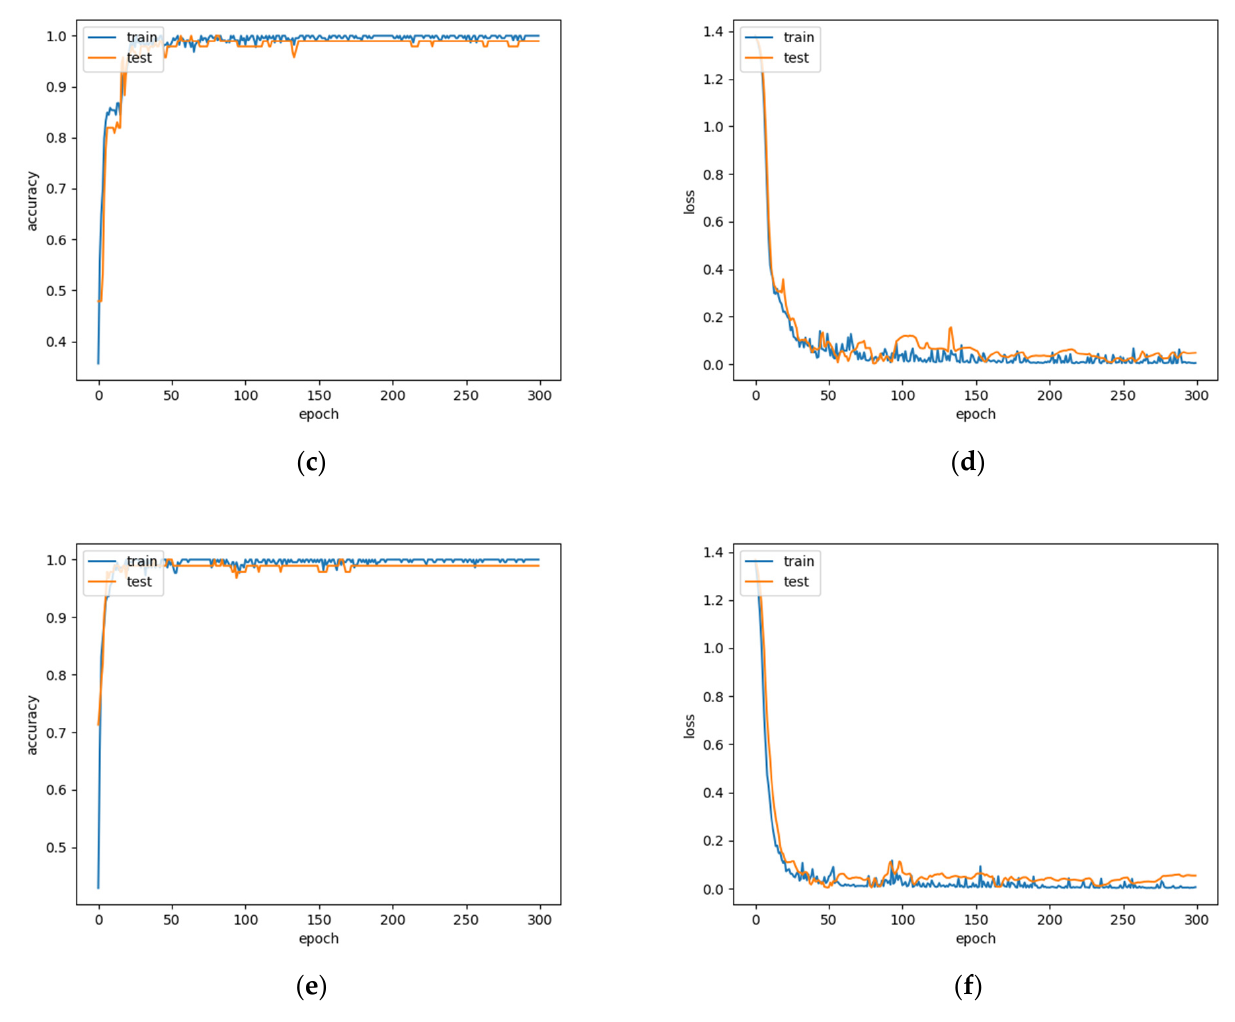
Figure 8. Accuracy and loss for girls’ physical fitness level evaluation. ( a , b ) Accuracy and loss when epoch is 250; ( c , d ) Accuracy and loss when epoch is 300; ( e , f ) Accuracy and loss when epoch is 350.